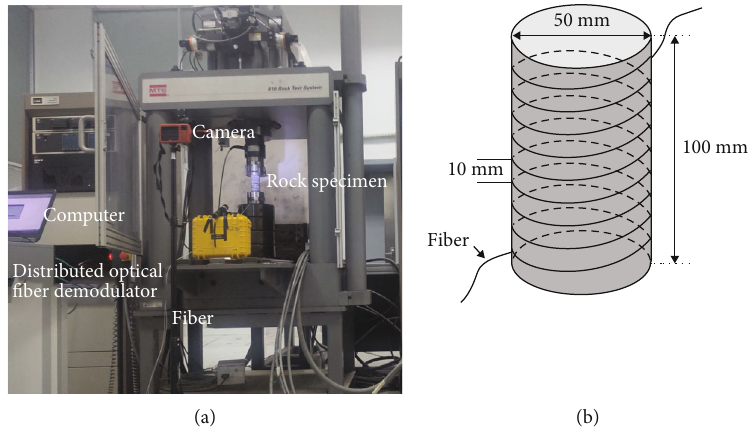
Figure 2: Schematic of the testing system (a) and rock sample and fi ber winding method